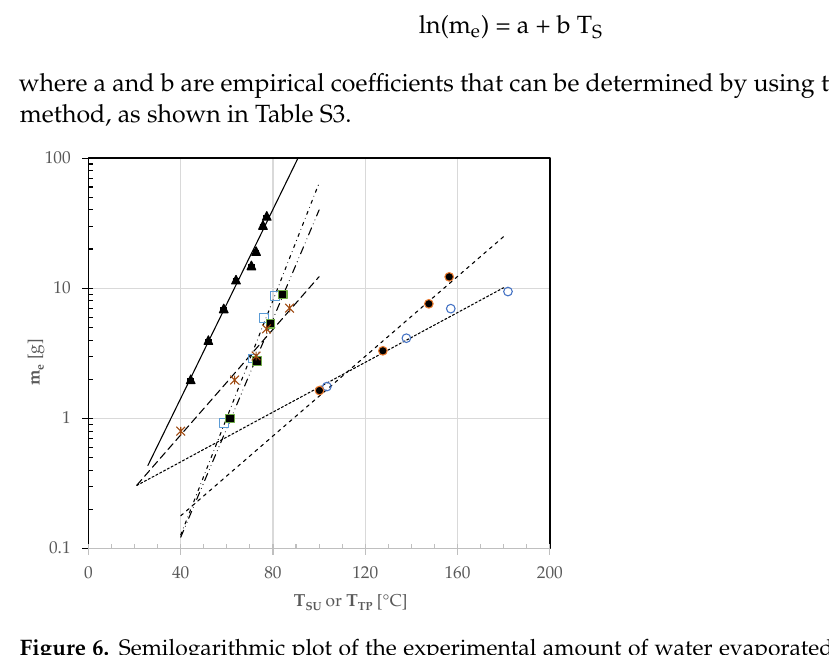
Figure 6. Semilogarithmic plot of the experimental amount of water evaporated (m e ) against the average sample temperature (T SU or T TP ) measured during either the water heating test ( (cid:78) , -) or different pizza baking tests (A: , . . . ; B: • , - - -; C: (cid:3) , - . -; D: (cid:4) , —. .—; E: ∗ , — — . The different regressions lines were calculated using Eq. (1) and the empirical coefficients listed in Table S3.